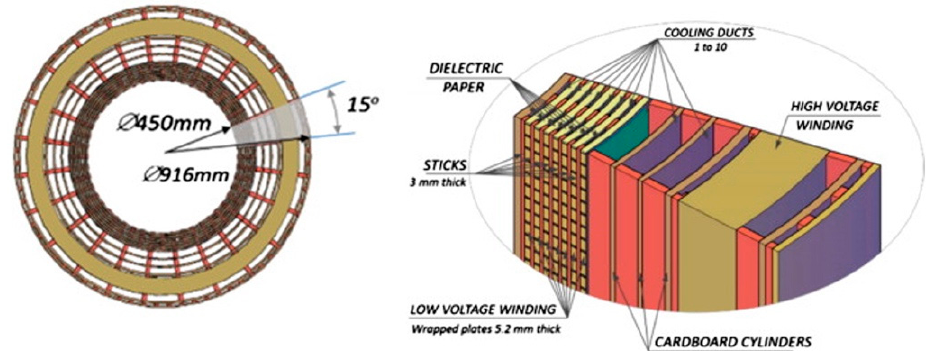
Figure 1. Plant view of a transformer phase with kraft paper.